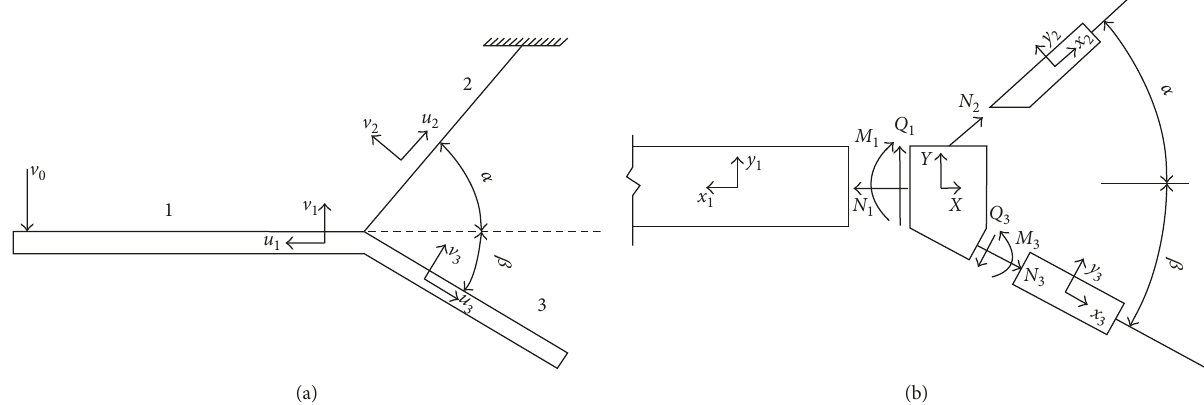
Figure 1: The displacement and stress of the three-member intersection. (a) The displacement of the components. (b) The internal forces of the